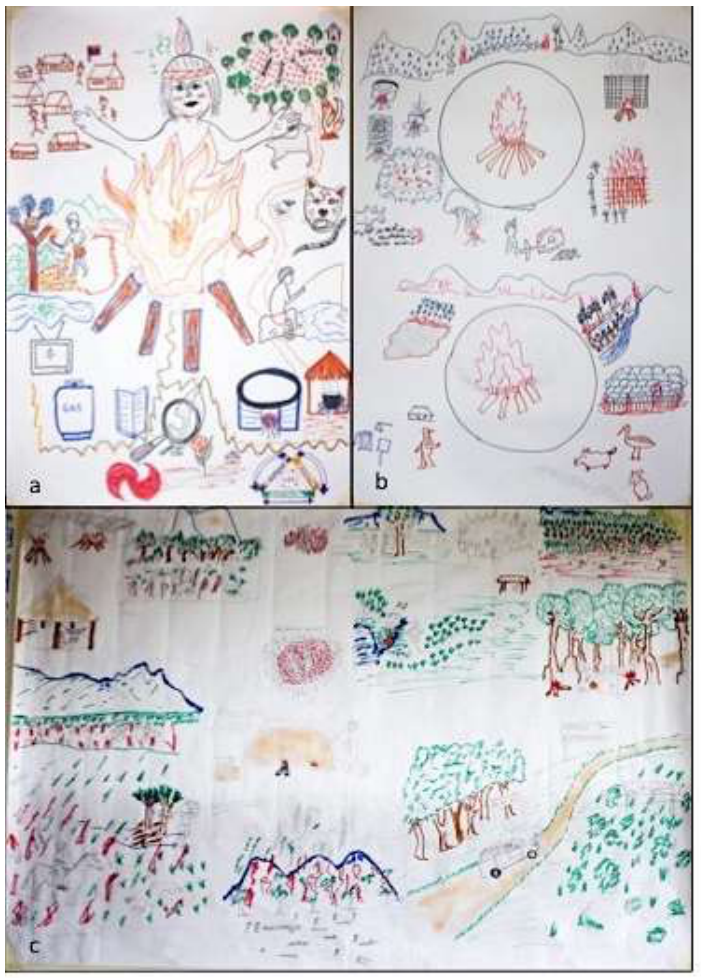
Figure 4. Rich pictures made by Indigenous groups: ( a ) Venezuela’s Indigenous group included members of the Pemón Indigenous communities (Bolivar State, Canaima National Park). ( b ) The Indigenous group from Brazil was integrated with members of the Macushi and Wapishana communities from the Ethnoregion Sierras da Lua and Indigenous Land Raposa Serra do Sol, Roraima State. ( c ) Indigenous participants from Guyana included members of the Macushi and Wapishana communities from the North Rupununi District Development Board (NRDDB) and the South-Central Peoples Development Association (SCPDA), respectively.